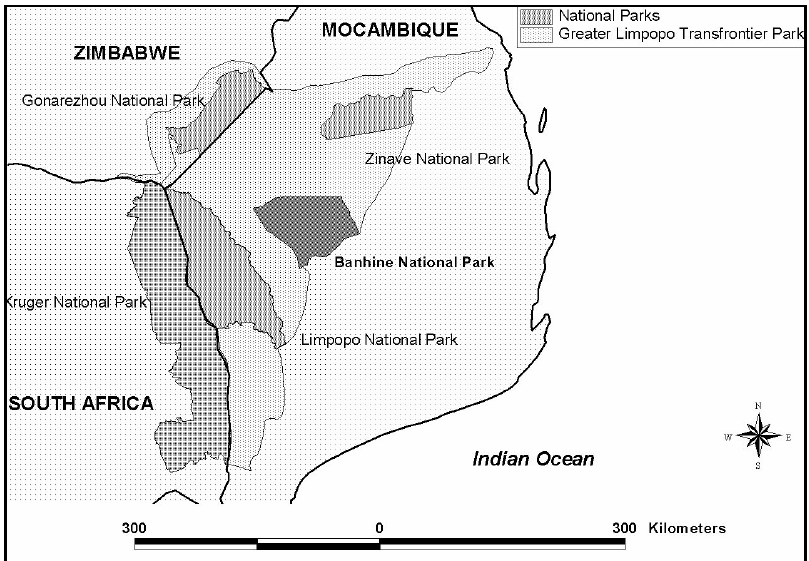
Fig. 1. Locality map of the Parque Nacional de